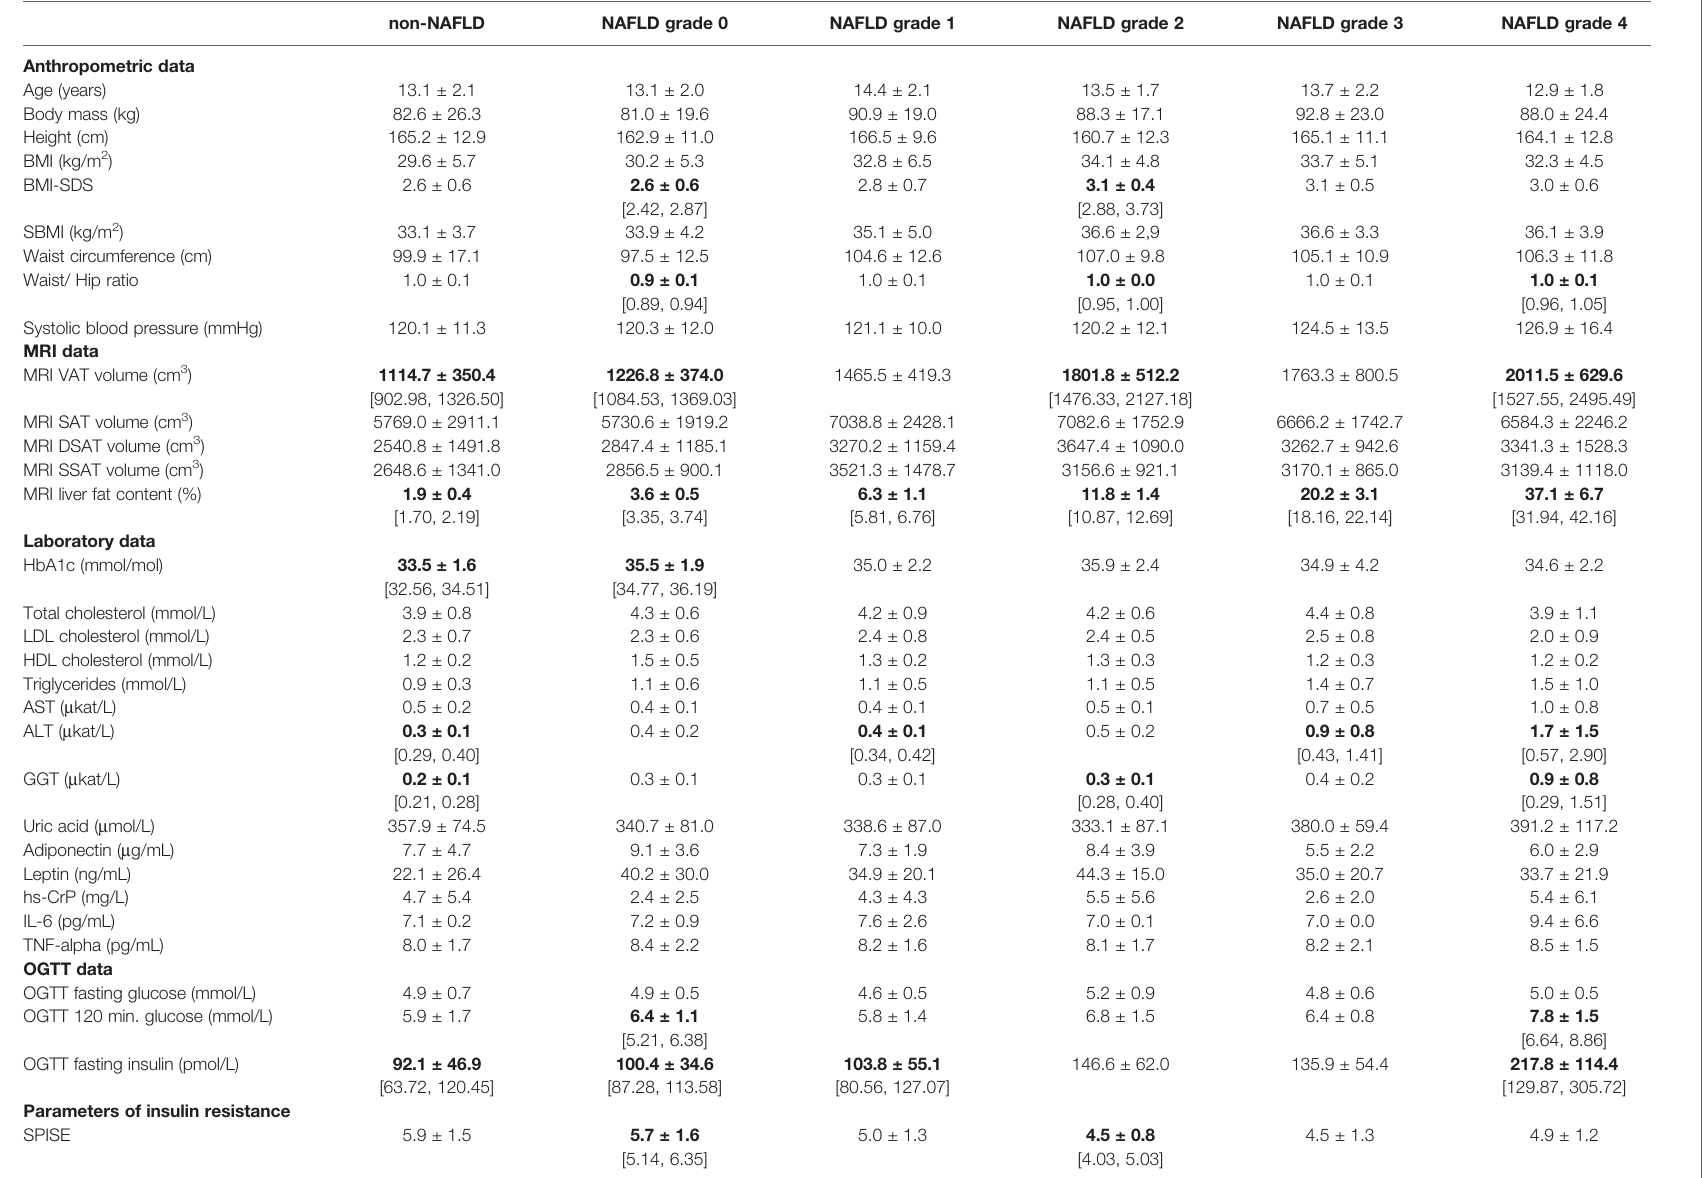
TABLE 3 | Descriptive data of NAFLD and non-NAFLD subjects according to grades of steatosis: non-NAFLD # : liver fat content (LFC) < 2.6%; grade 0 + : LFC 2.6 - ≤ 5%; grade 1 § : LFC >5 - ≤ 9.2%; grade 2 % :